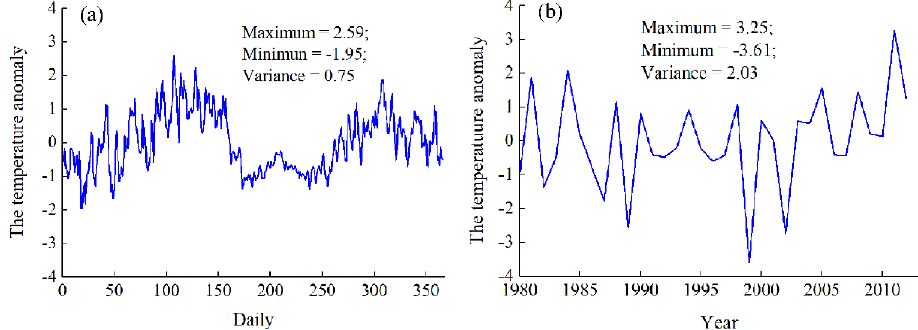
Figure 8. ( a ) anomalies of the daily range and ( b ) anomalies of the annual range.